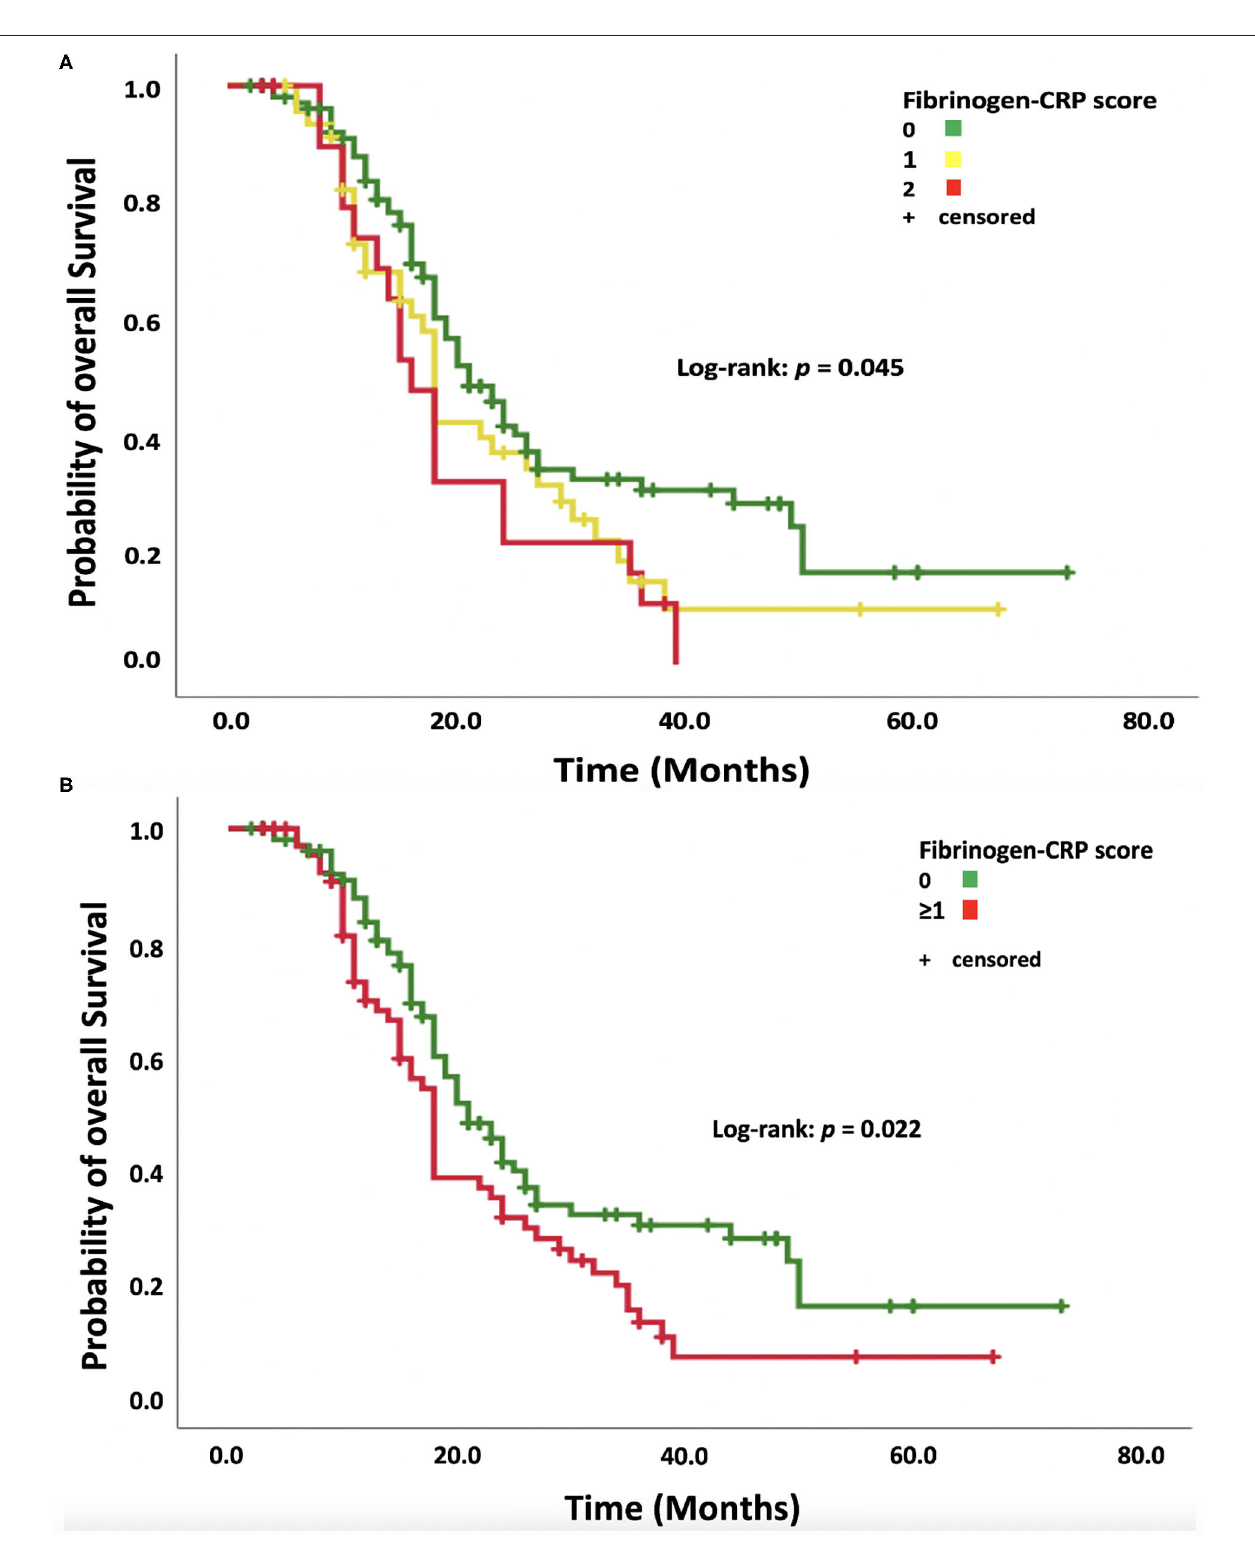
FIGURE 2 | (A) Kaplan–Meier analysis of survival probability stratified according to fibrinogen–CRP scores of 0, 1, and 2. Censored patients (alive at last follow-up) are indicated on the curves. The time axis is right-censored at 80 months. p = 0.045 (log-rank test). (B) Kaplan–Meier analysis of the survival probability stratified by dichotomized fibrinogen–CRP scores of 0 and ≥ 1. Censored patients (alive at last follow-up) are indicated on the curves. The time axis is right-censored at 80 months. p = 0.022 (log-rank test).